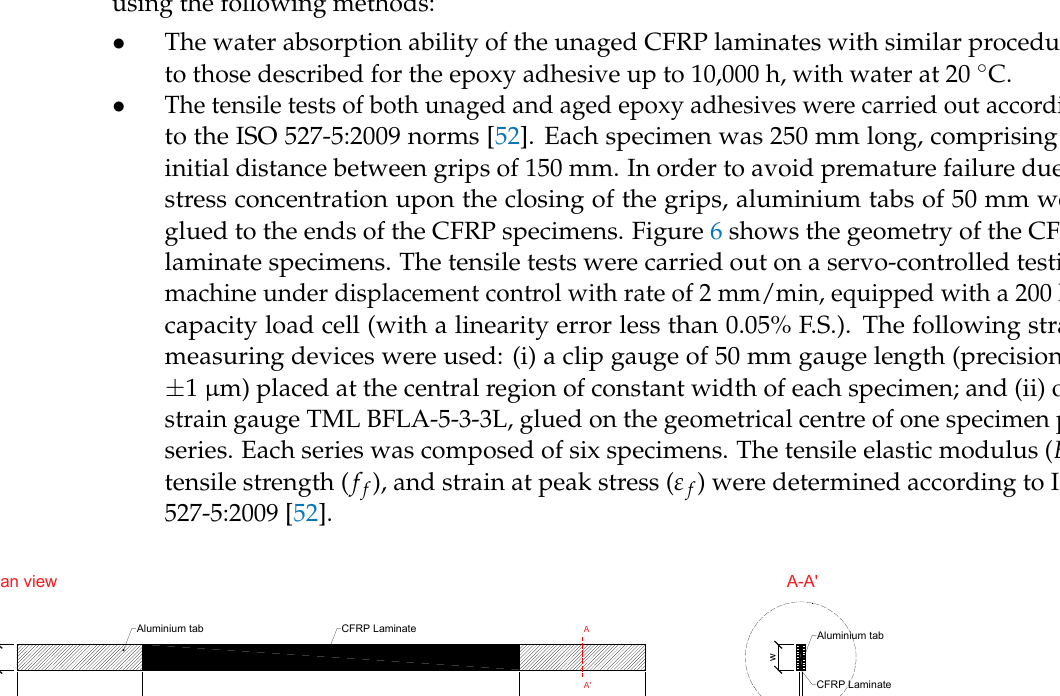
Figure 6. Geometry of the CFRP laminate strip specimens used in the tensile tests. All units in (mm).